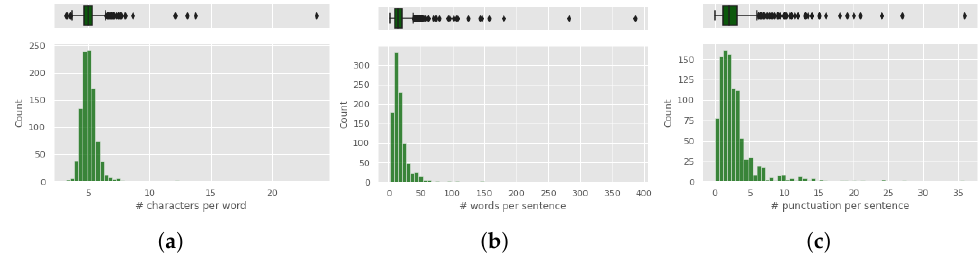
Figure 6. Complexity attributes of fake news items: ( a ) average No. of characters per word, ( b ) aver- age No. of words per sentence and ( c ) average No. of punctuation per